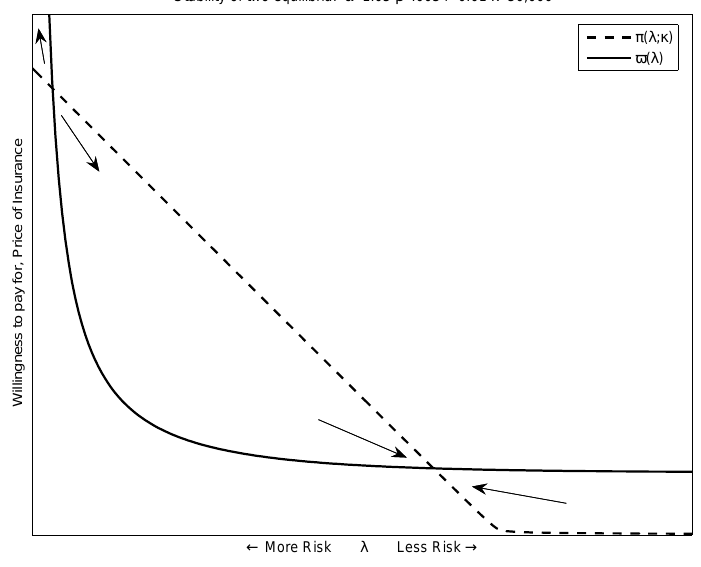
Figure 3. The stability of two